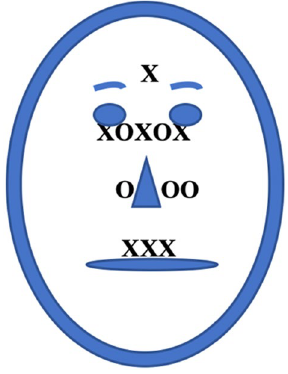
Figure 1. Number of prior studies indicating gaze tendencies at particular face regions in Easterners and Westerners. Note. X: Westerners, O: Easterners. For example, three prior studies indicate substantial